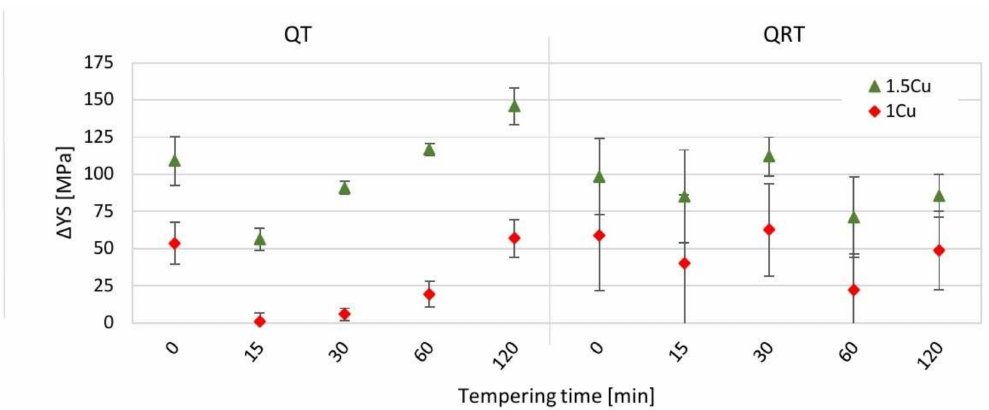
Figure 9. Di ff erence ∆ YS between YS of Cu-alloyed materials and 0Cu samples tempered at 400 ◦ C. YS of 0Cu samples is the